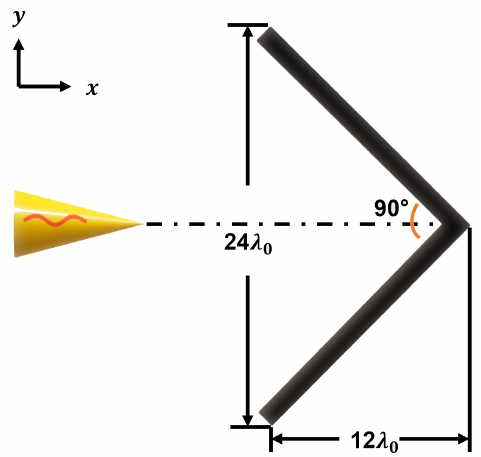
Figure 1. (Color online). The schematic diagram of an ultra-intense laser pulse irradiating a carbon cone